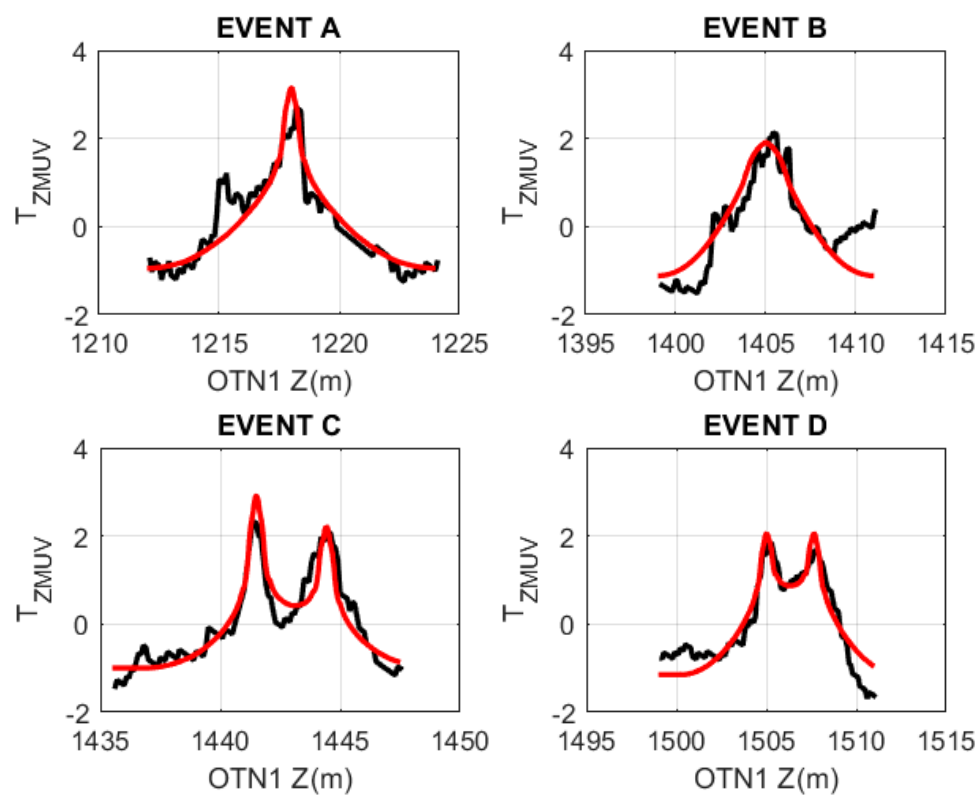
Figure 10. Overlays of Figure 5 model wellbore axial temperature profiles (red traces) for 30 cm radius wellbore embedded in a 10-m radius crustal volume superposed on OTN1 wellbore temperature events A, B, C, and D (black traces). OTN1 event depths are given on horizontal axes; event/model temperatures are normalized to zero-mean/unit-variance format. The favoured model flow channel thickness is 0.6 m, as illustrated in Figure 7. The observed flow channel events occur either singly or in pairs. ( Upper Left ) Model temperature profile computed for single 0.6 m thick flow channel. ( Upper Right ) Model temperature profile for 2–3 m thick flow channel. ( Lower Left ) Model temperature profile for 4-m spaced pair of 0.6 m thick flow channels. ( Lower Right ) Model temperature profile for 3-m spaced pair of 0.6 m thick flow channels.